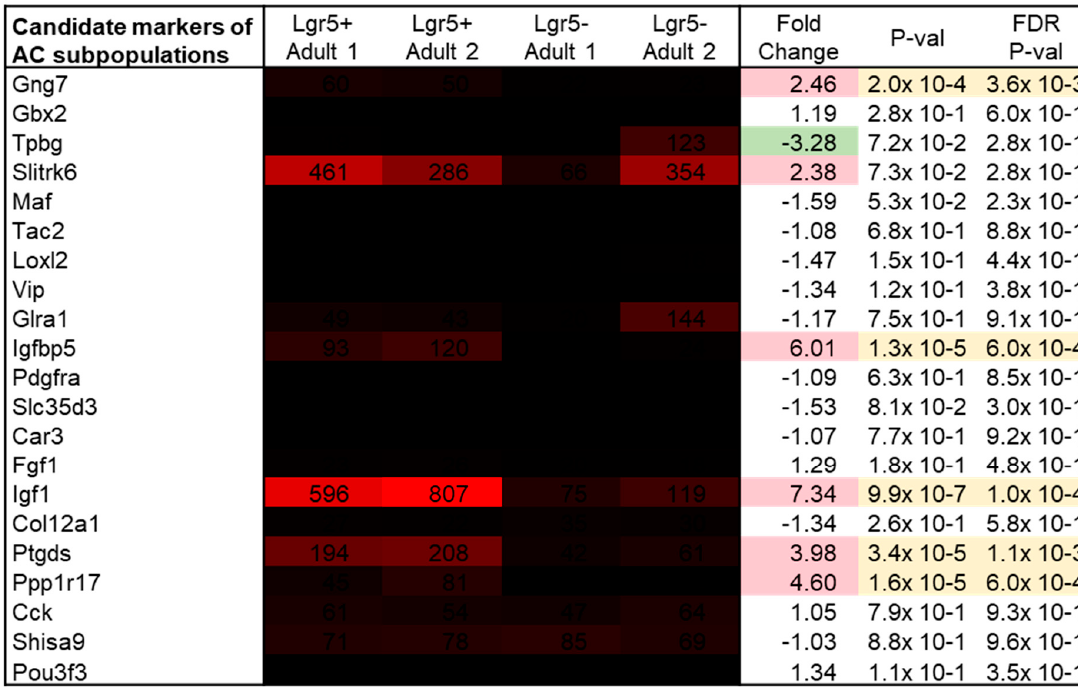
Figure 5. Gene expression levels and fold changes of nGnG cell markers in PN5 tissue. Fold change shows high expression values of Ebf3 in PN5 Lgr5 + cells. Differentially expressed genes were defined by a fold change ≥ 2 or ≤ − 2, p -value < 0.05, and false discovery rate (FDR) < 0.05. By single cell RNA-sequencing Macosko et al. discovered candidate markers of amacrine subpopulations [12]. Therefore, expression of these markers in Lgr5 + cells was analyzed. The highest expression and significant fold change was seen for the marker Igf1, with a mean signal value of 701 and fold change of 7.34 (Figure 6; p = 9.9 × 10 − 7 ). Two other markers showed signal values of above 100 and significant upregulation, namely Ptgds (mean: 201, FC: 6.73, p = 5.3 × 10 − 7 ) and Igfbp5 (mean: 106; FC: 6.01, p = 1.3 × 10 − 5 ).